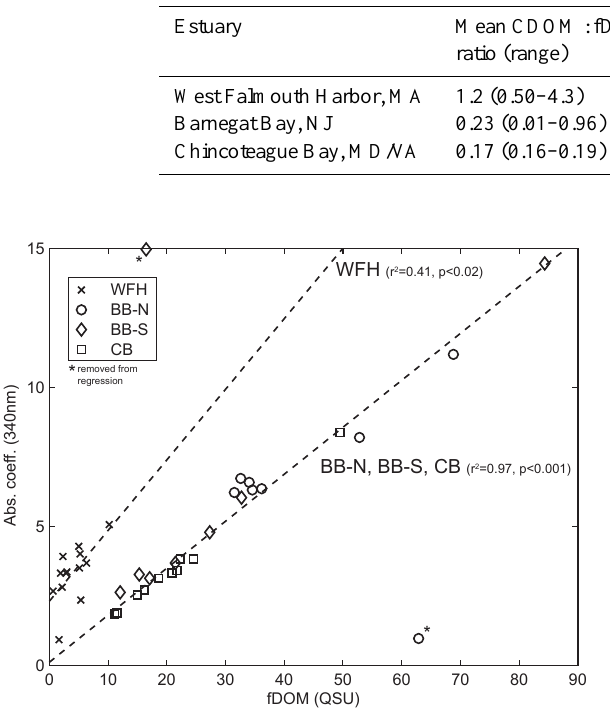
Figure 3. Absorption coefficient at 340nm versus fluorescence measurement for all sampling sites at West Falmouth Harbor (WFH), North Barnegat Bay (BB-N), South Barnegat Bay (BB-S), and Chincoteague Bay (CB). Dashed lines indicate the best linear fit to the data, with associated r 2 and p value. Two outliers (indicated by asterisks) removed from the regressions for Barnegat